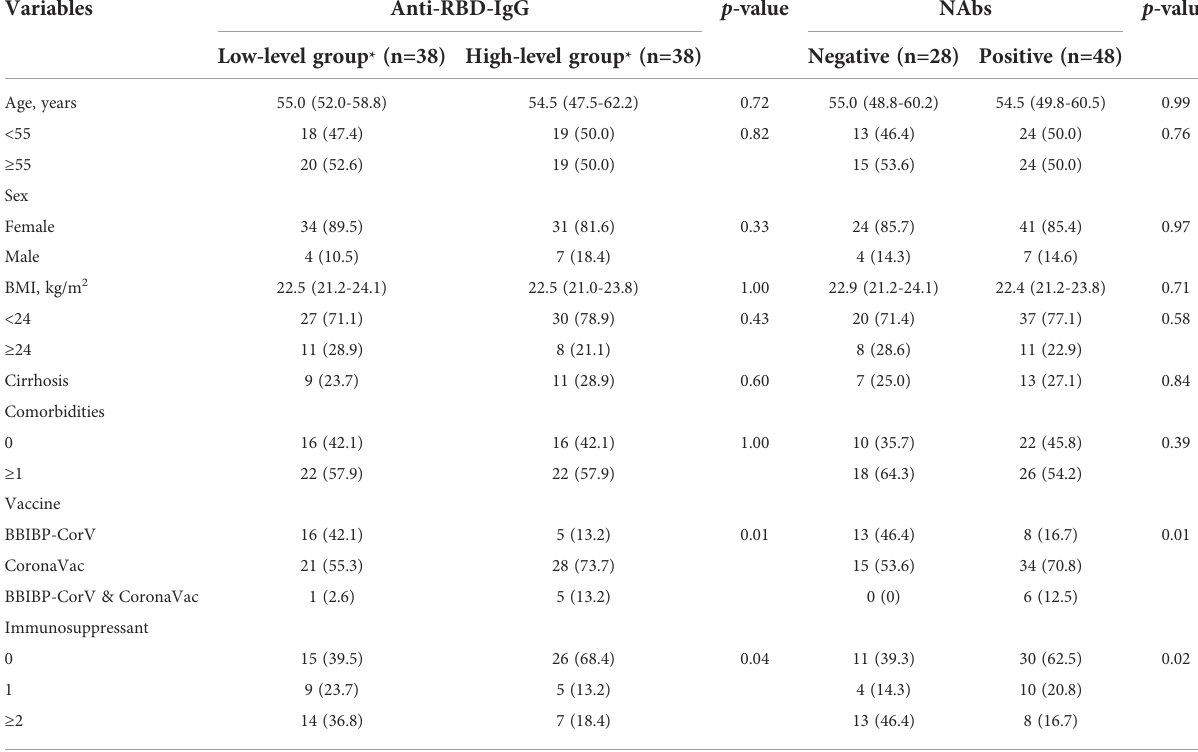
TABLE 3 Distribution of clinical characteristics by serum antibody titers to SARS-CoV-2 vaccine in patients with